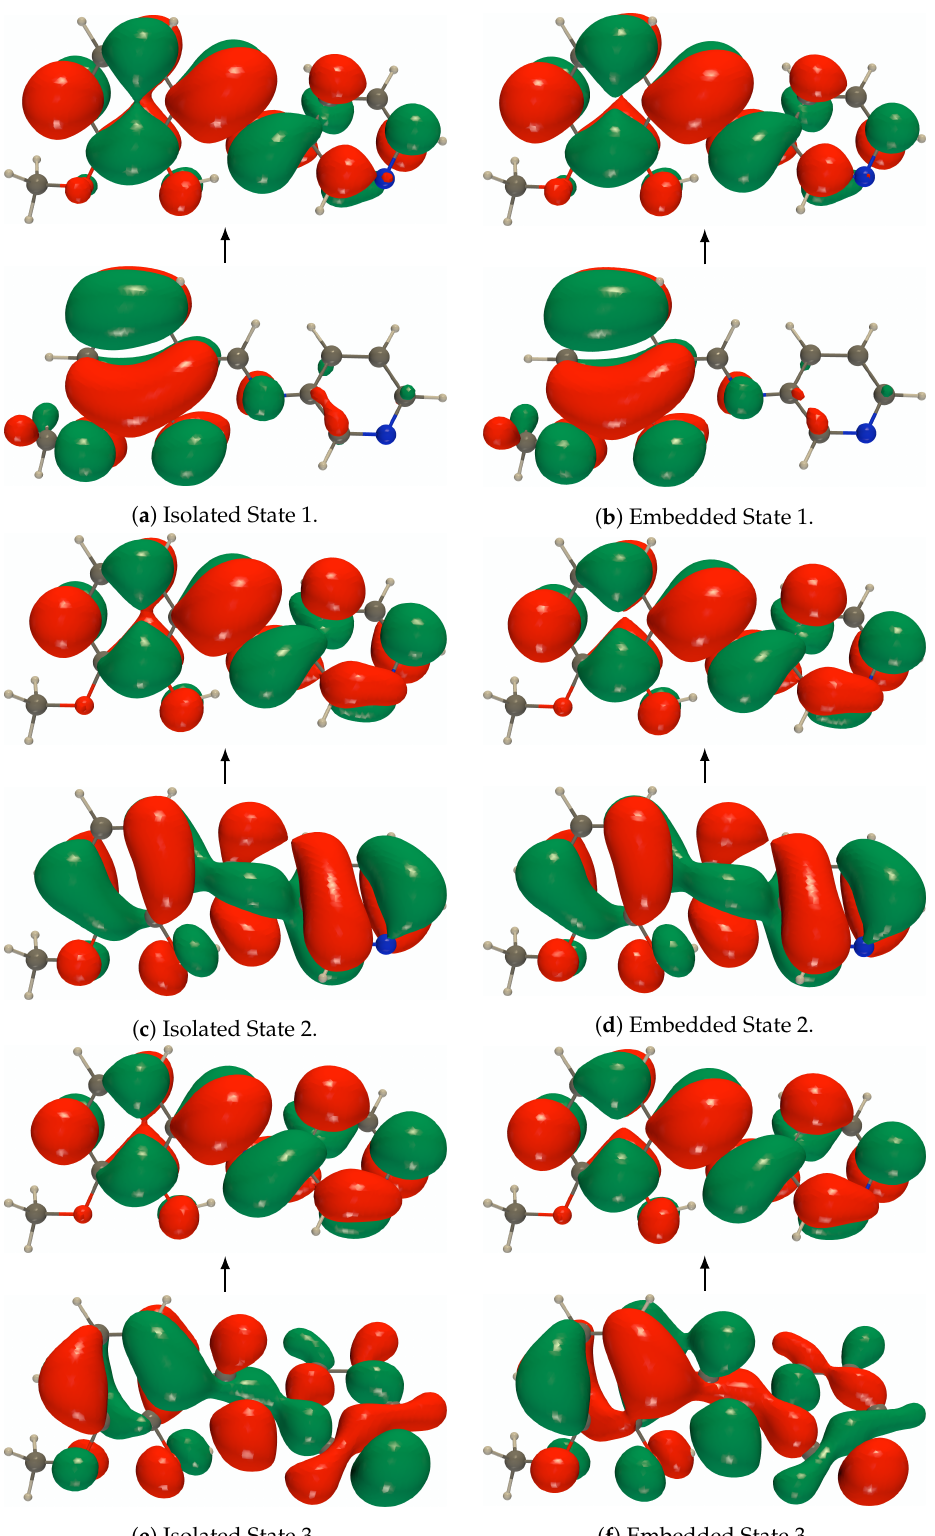
Figure A5. RI-CC2/def2-TZVPD NTOs (holes below the arrows and particles above them, the red (green) lobes are the positive (negative) ones) of the isolated and embedded PYV3 [PYV3] enol form (isovalue of